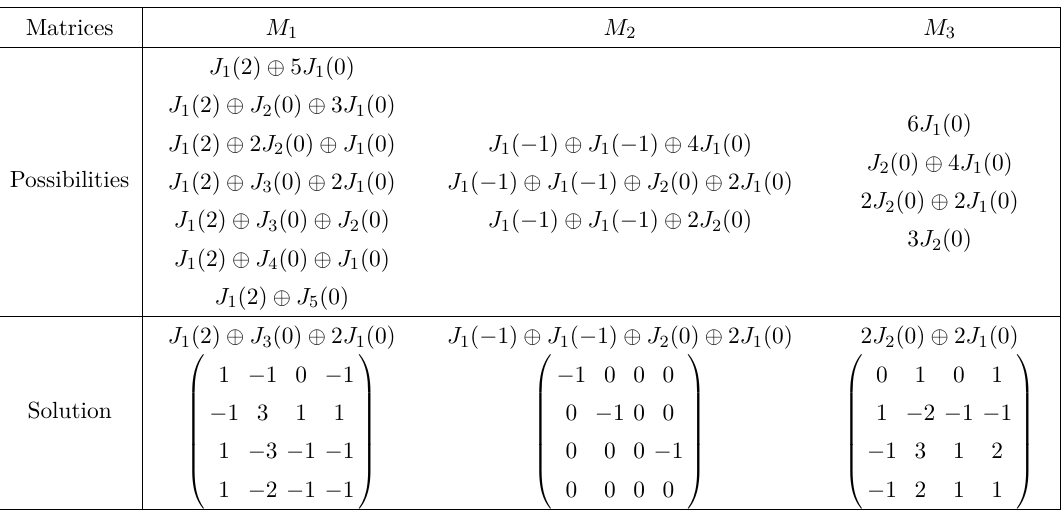
Table 2 . Solutions for the FI deformations (3.11). Note that a trivial block 2 J 1 (0) appears in the solution everywhere, and we show only the non trivial 4 × 4 block in the explicit